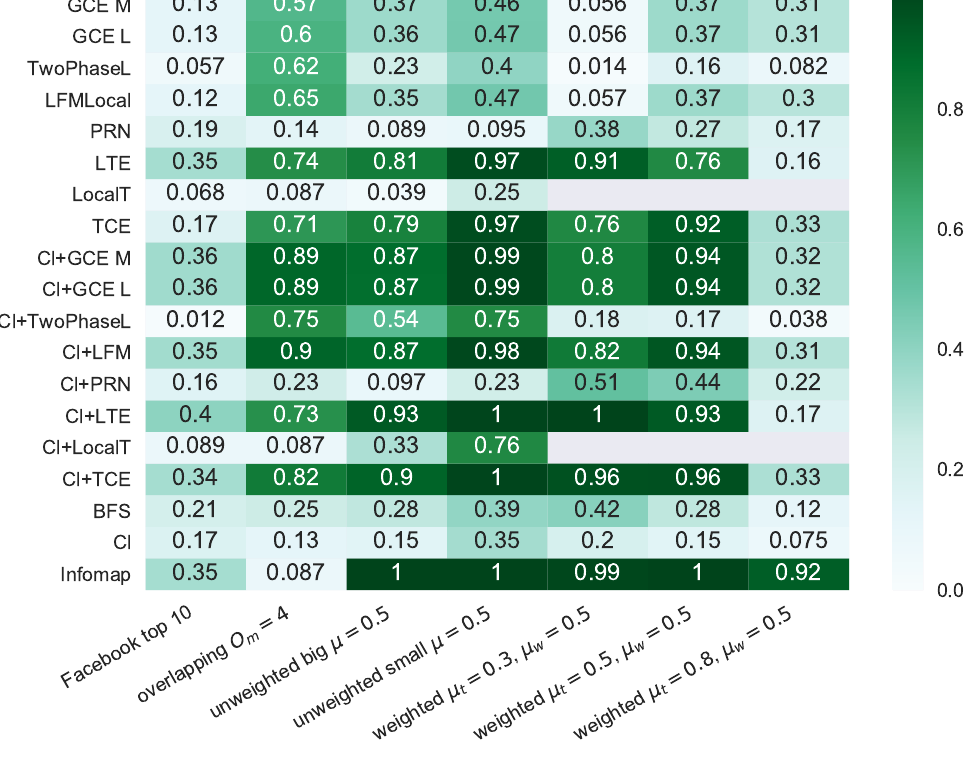
Figure 6. Summary of F1-Score - seed values of all types of networks considered. The results for the Facebook networks are averages over the 10 networks where “Cl+LTE” had the best scores. LocalT does not support edge weights and is therefore omitted for weighted